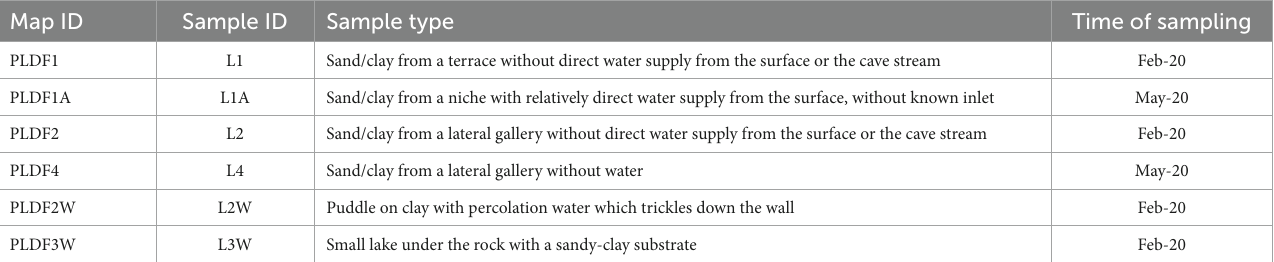
TABLE 1 Details and description of the cave samples analyzed in the present